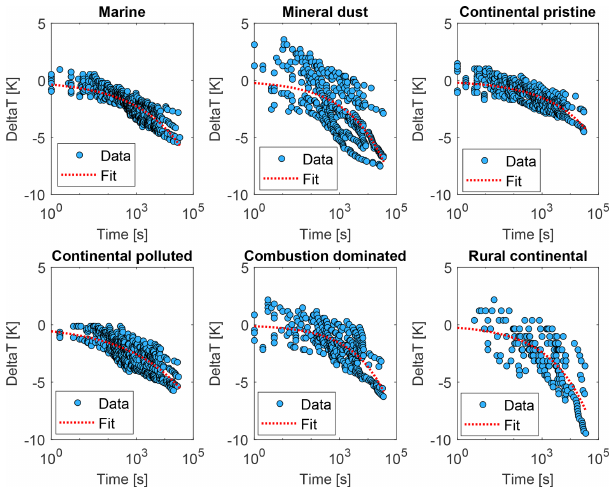
Figure 13. The apparent temperature shift, (cid:49)T , required to match the empirical parameterization of INP activity (Phillips et al., 2013) with the measurements of frozen fraction from the isothermal exper- iments (blue dots), for the marine, mineral-dust-influenced, conti- nental pristine, continental polluted, combustion-dominated and ru- ral continental samples of aerosol material (panels from top left to lower right). Evolution over time since the start of the isothermal phase is displayed. Also shown is the fit (Eq. 6) assuming a power law dependent on time (dotted red